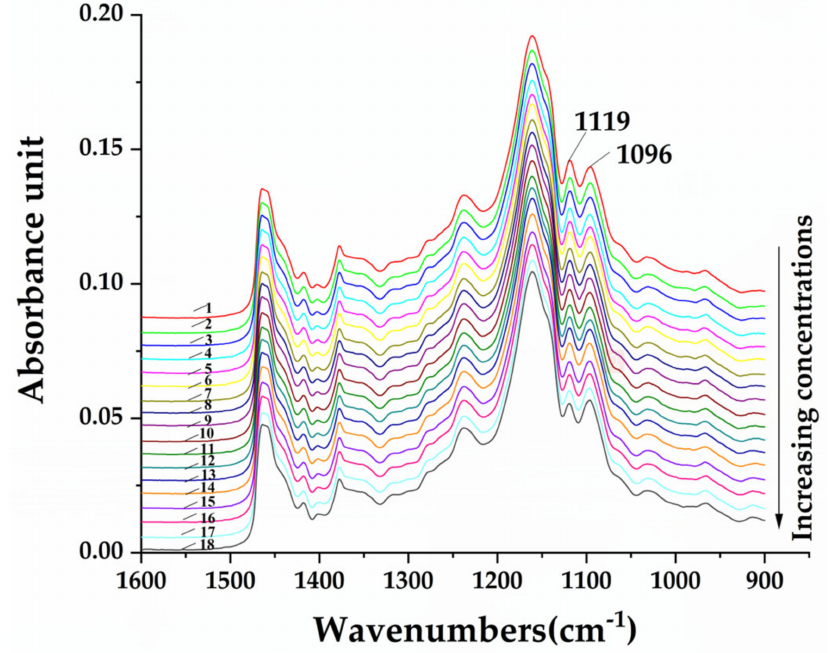
Figure3. FTIRspectraofpureCAOandCAO / RSOadmixtures(1–90% v / v )intheregionof1600–900cm − 1 .